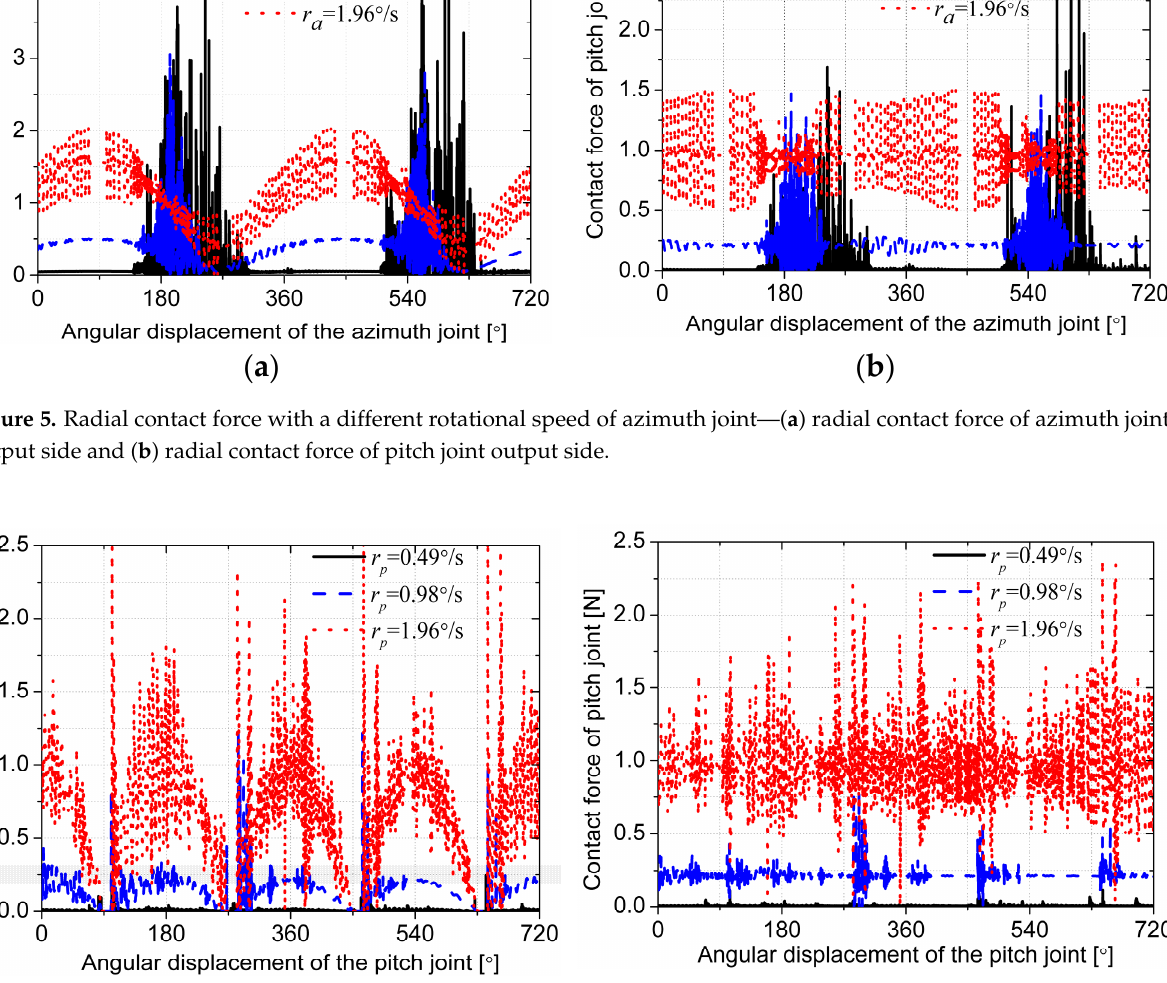
Table 3. Simulation parameters of radial clearance.